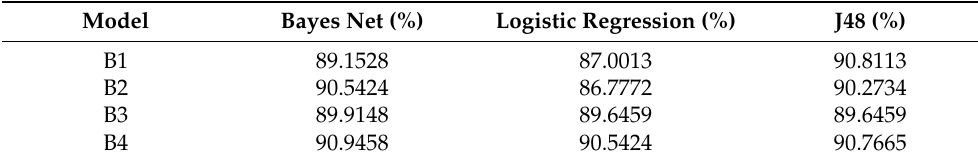
Table 7. Models B1-B4 net profit decision (comparison table).